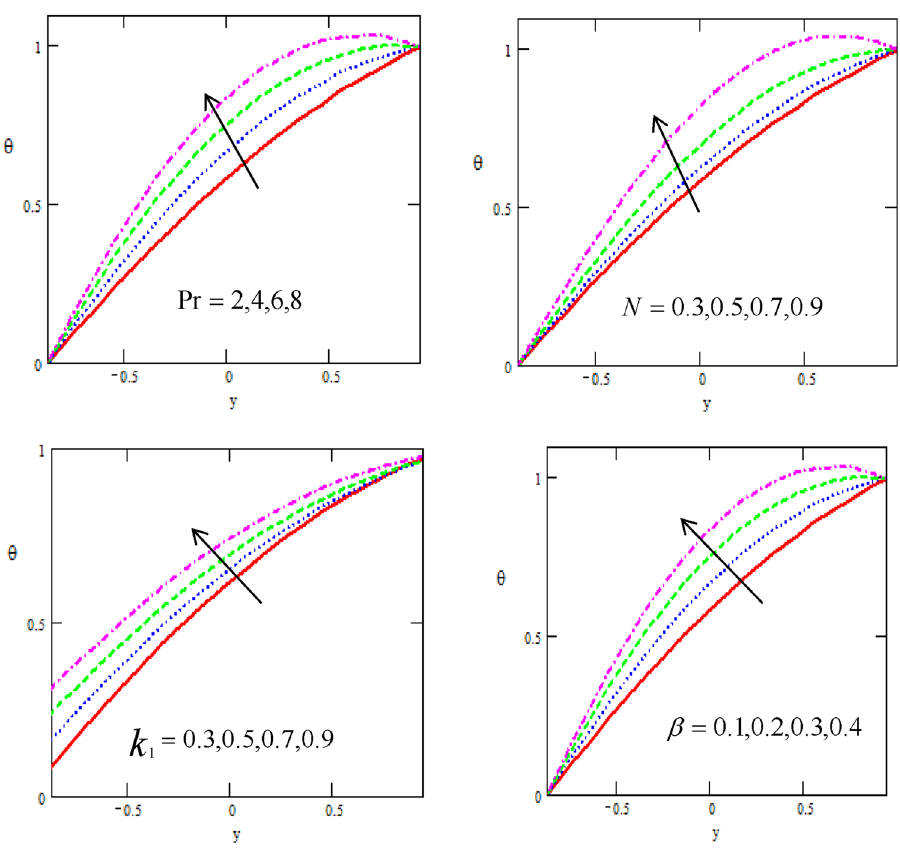
Figure 3. Variation of the Temperature θ concerning the axial-y with different values of N , k 1 , Pr, β